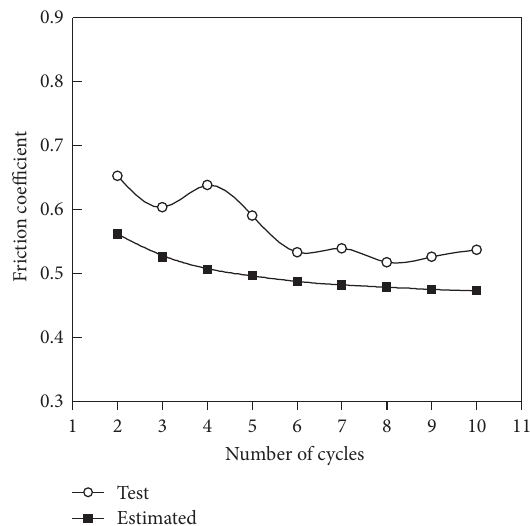
Figure 10: Comparison between the test value and the estimated value with